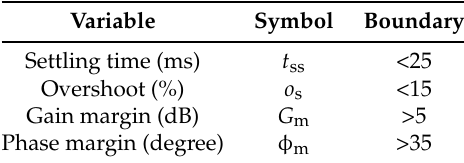
Table 2. Tuning boundaries of the current controller.